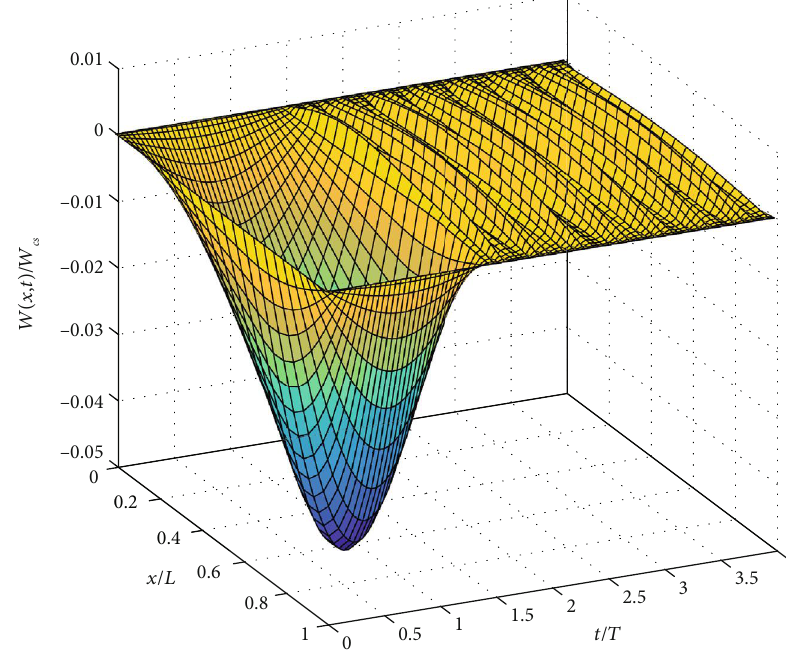
Figure 15: Time-space response of S-S beam subjected to a sinusoidal impulse for t